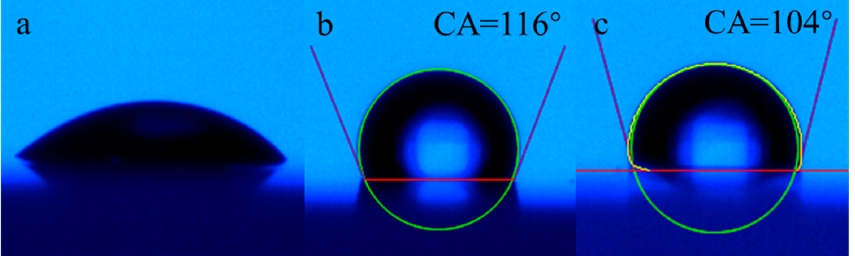
Figure 14. Oleophobicity of untreated and treated co tt on fabric. ( a ): untreated co tt on fabric fi nished by white mineral oil, ( b , c ): treated co tt on fi nished by n-hexadecane and n-tetradecane, respectively.